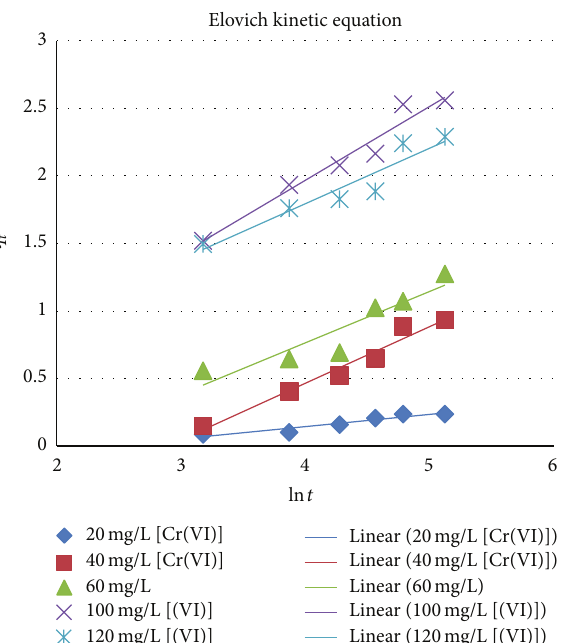
Figure 5: The Elovich kinetic model, pH 2.5, ambient temperature, and absorbent dose of